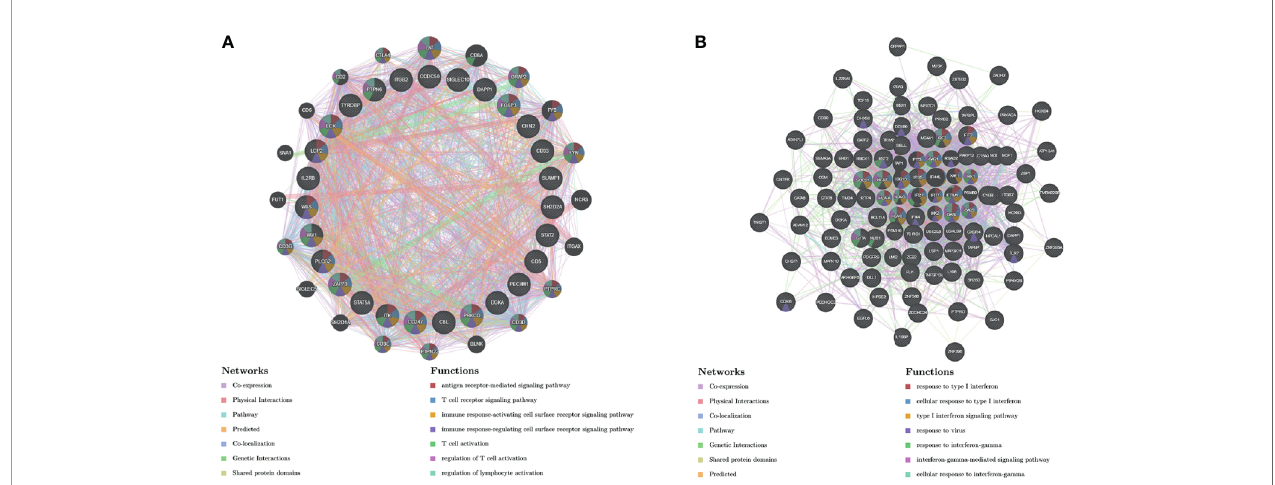
FIGURE 7 | Protein – protein interaction network of LCK kinase and transcription factor IRF-target networks (GeneMANIA). PPI network and functional analysis indicating the gene set that was enriched in the target network of (A) LCK kinases and (B) transcription factor IRF. Distinct colors of the network edge indicate the bioinformatics methods applied; distinct colors for the network nodes indicate the biological functions of the sets of enrichment genes. PPI, protein – protein